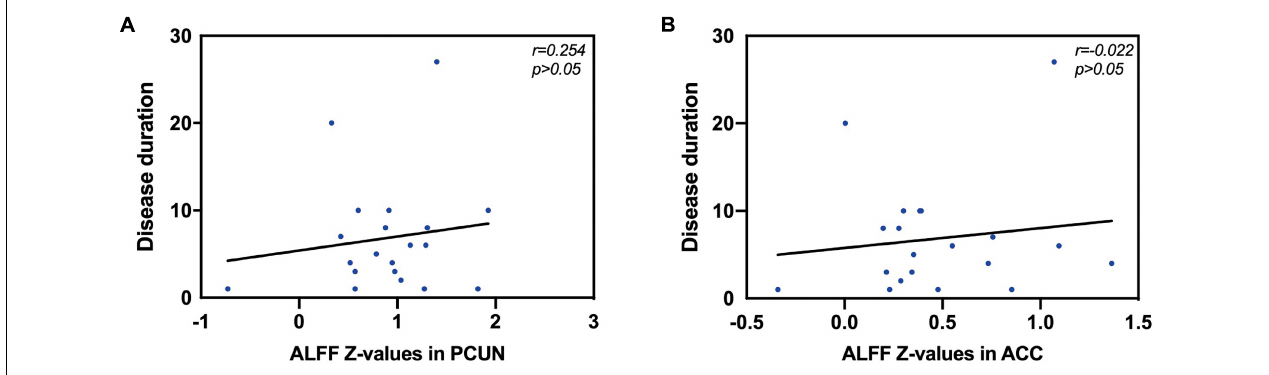
FIGURE 6 | Correlation analysis between disease duration (years) and the ALFF values in the PCUN and ACC. (A) Correlation analysis between disease duration and the ALFF values in the PCUN: n = 20, r = 0.254, p > 0.05. (B) Correlation analysis between disease duration and the ALFF values in the ACC: n = 20, r = 0.022, p > 0.05. ALFF, amplitude of low-frequency fluctuation; PCUN, precuneus; ACC, anterior cingulate cortex. TABLE 3 | Estimation results of the multivariate linear regression coefficients on the ALFF z -values in the PCUN and ACC. Factor